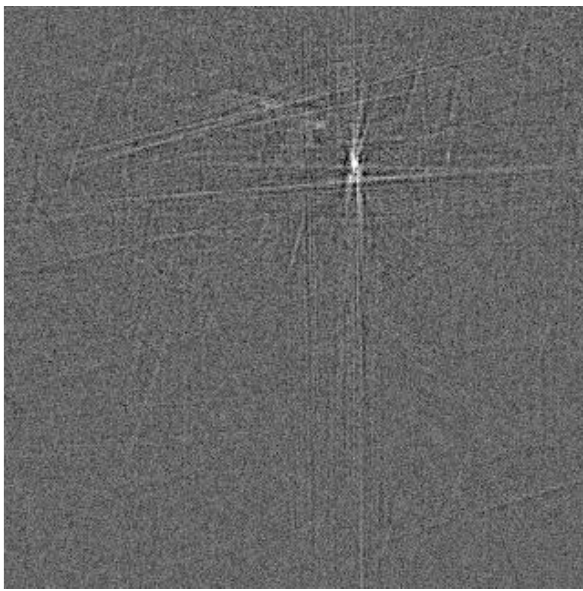
Figure 4 | Phase correlation diagram. White is positive, black is negative correlation.